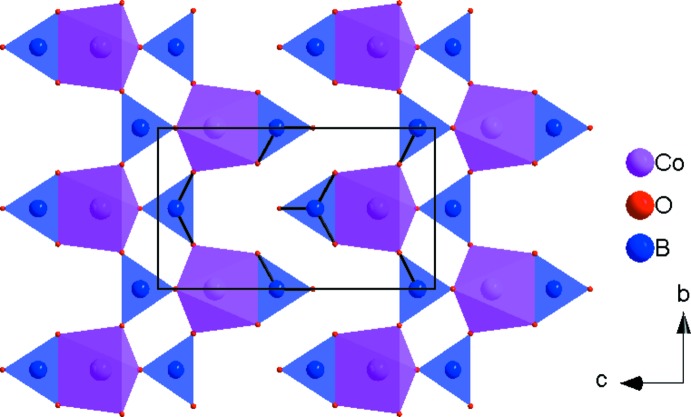
Edge- and corner-sharing [CoO5] and (BO3) polyhedra forming branched rows parallel to [010].